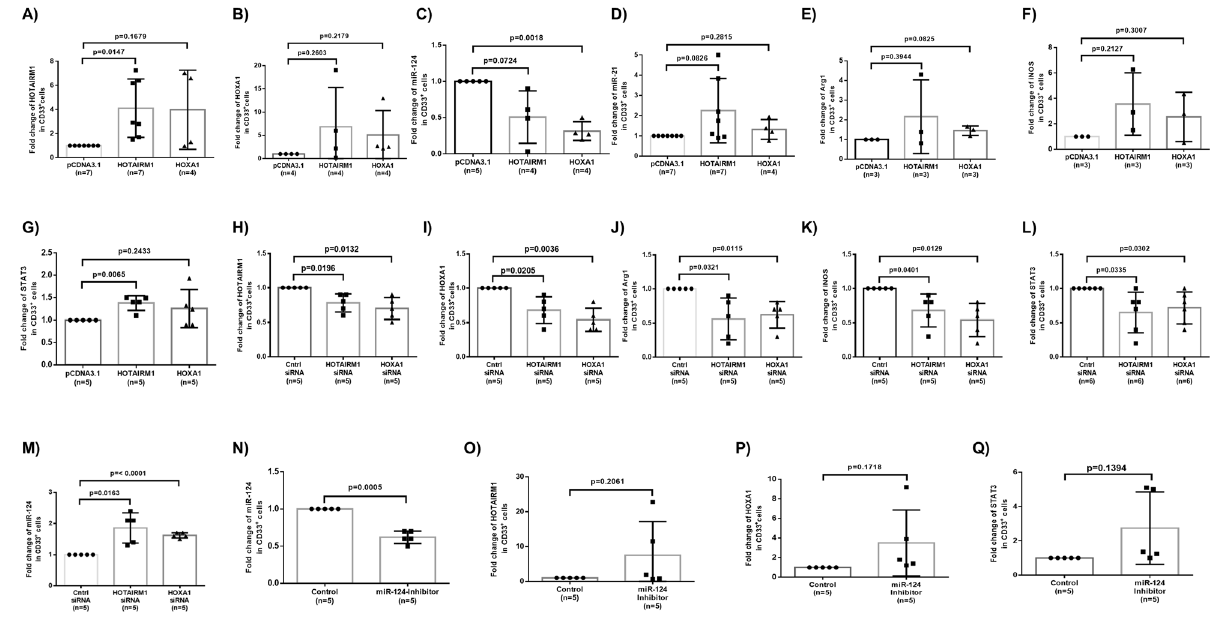
Figure 4. HOTAIRM1 and HOXA1 regulate each other and control miR124 expression in MDSCs. ( A–B ) HOTAIRM1 or HOXA1 expression levels in CD33 + cells transfected by pcDNA3.1 control, HOTAIRM1, or HOXA1 plasmids. ( C–D ) miR124 or miR21 expression levels in CD33 + cells transfected by pcDNA3.1 control, HOTAIRM1, or HOXA1 plasmids. ( E–G ) Arg1, iNOS, or STAT3 expression levels in CD33 + cells transfected by pcDNA3.1 control, HOTAIRM1, or HOXA1 plasmids. ( H–I ) HOTAIRM1 and HOXA1 expression in HCV- derived CD33 + cells transfected with HOTAIRM1, HOXA1, or control siRNA. ( J–M ) Arg1, iNOS, STAT3, and miR124 expression levels in HCV-CD33 + cells transfected with HOTAIRM1, HOXA1, or control siRNA. ( N–Q ) Expression levels miR124, HOTAIRM1, HOXA1, and STAT3 in HCV-CD33 + cells transfected with control or miR124